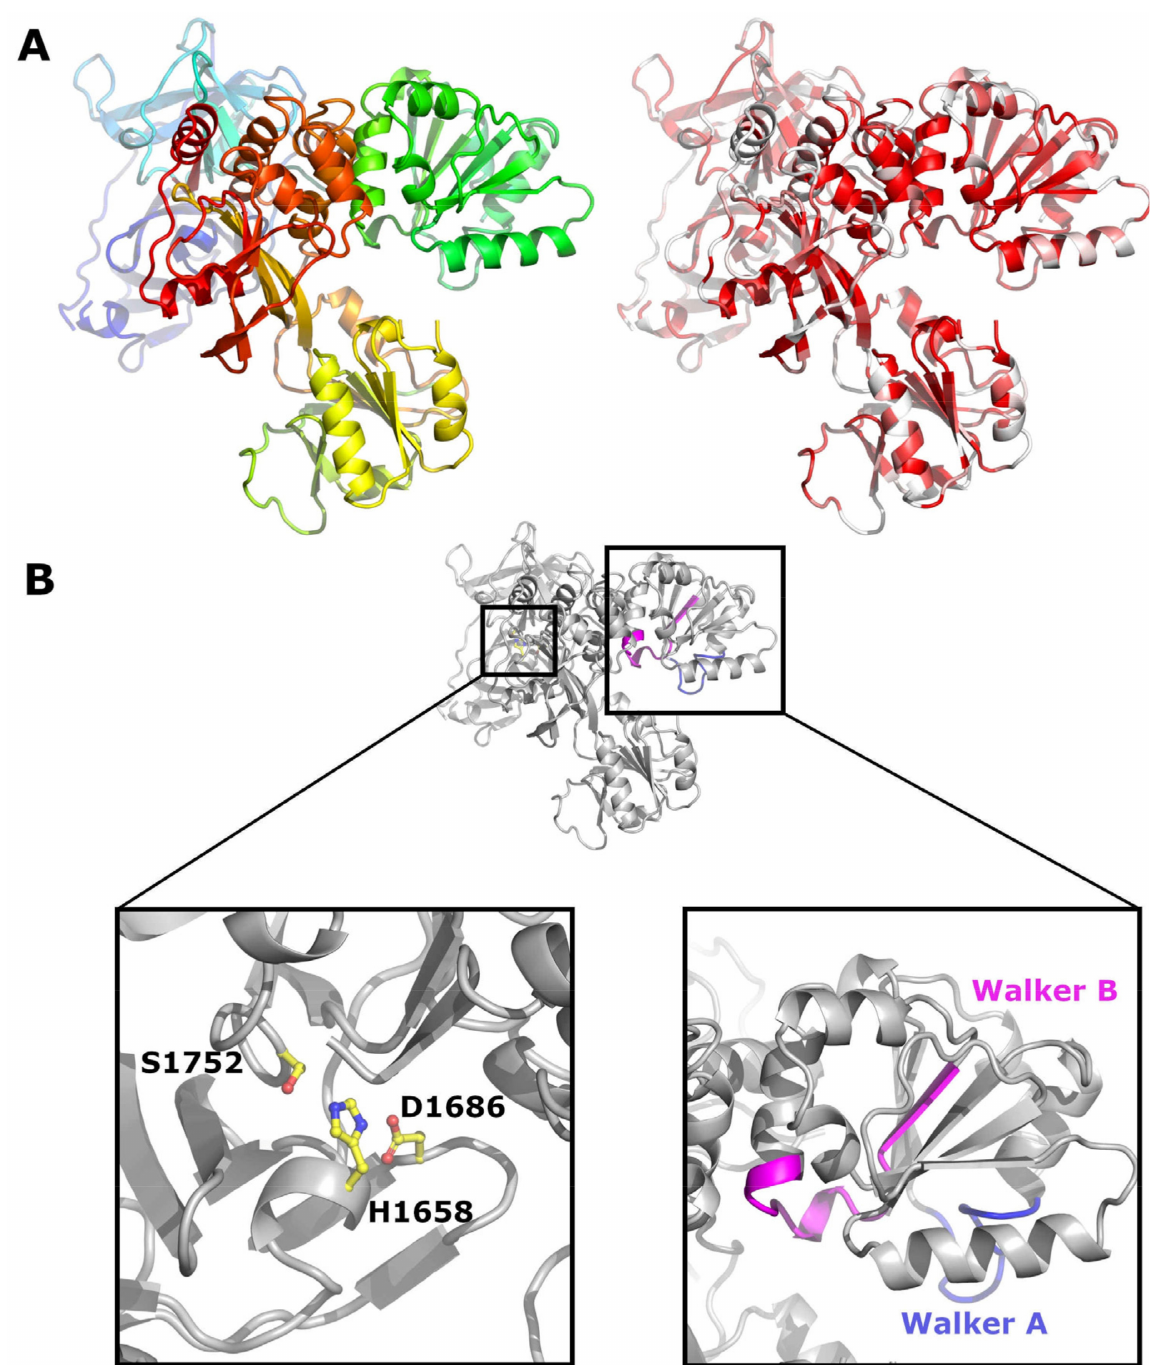
Figure 7. Crystal structure of CSFV NS3. ( A ) Cartoon representation of NS3 (PDB code 5WX1). On the left, NS3 is coloured from the N terminus (blue) to the C terminus (red). On the right, NS3 is coloured according to sequence conservation from white (non-conserved) to red (conserved). ( B ) On the left, residues forming the catalytic triad are shown as sticks; on the right, the Walker motifs A and B are coloured in blue and magenta